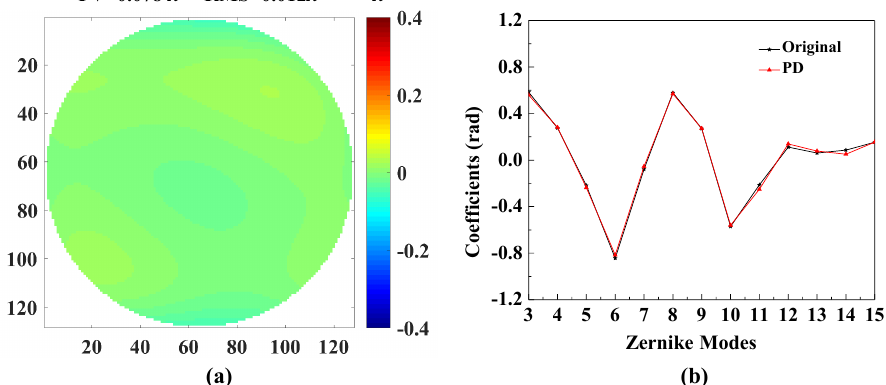
Figure 11. The result of the PD model of PD-CNN. ( a ) The residual wavefront and ( b ) the comparison of the Figure 8b and the estimated Zernike coefficients. The unit of residual wavefro nt is λ . The unit of estimated Zernike coefficients is rad.